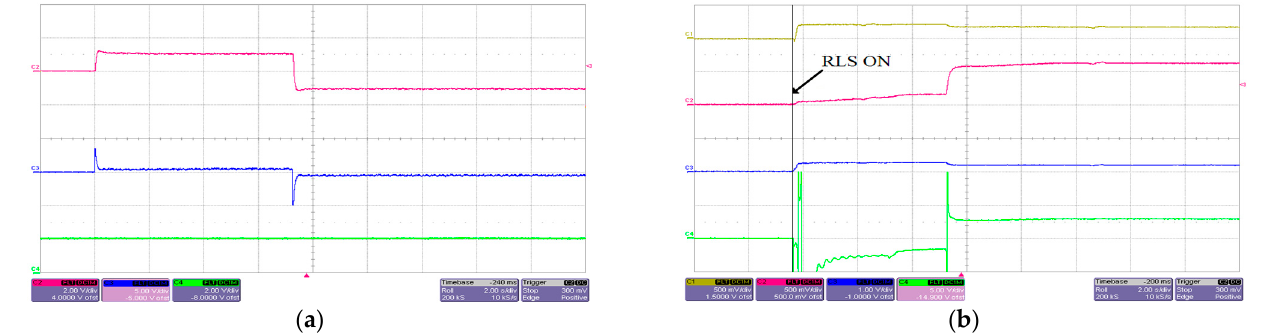
Figure 6. Experimental results: identification of observers parameters using self-tuning algorithm—acceleration from 0 to 100 rpm and reversal to − 100 rpm, no load; ( a ) measured speed (red), flux (green) and torque (blue) producing stator current components; ( b ) observer parameters K 1(CB) (yellow), K 2(CB) (red), K 3(CB) (blue), 1/T i(CB) (green). Scales: speed—200 rpm/div; currents—1 A/V; K 1(CB) , K 2(CB) —0.5/div; K 3(CB) —1/div; 1/T i(CB) —500/div; time—2 s/div. Table 2. Comparison of estimated parameters.